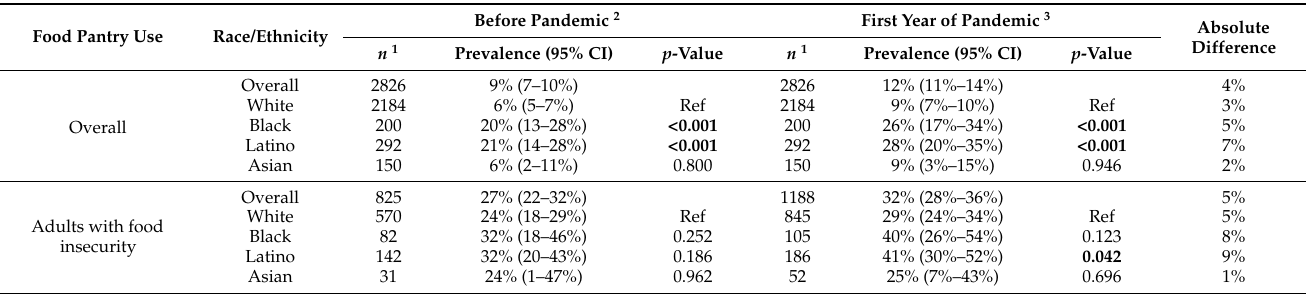
Table 2. Prevalence of food pantry use before and in the first year of the pandemic overall and among those experiencing food insecurity by race/ethnicity.